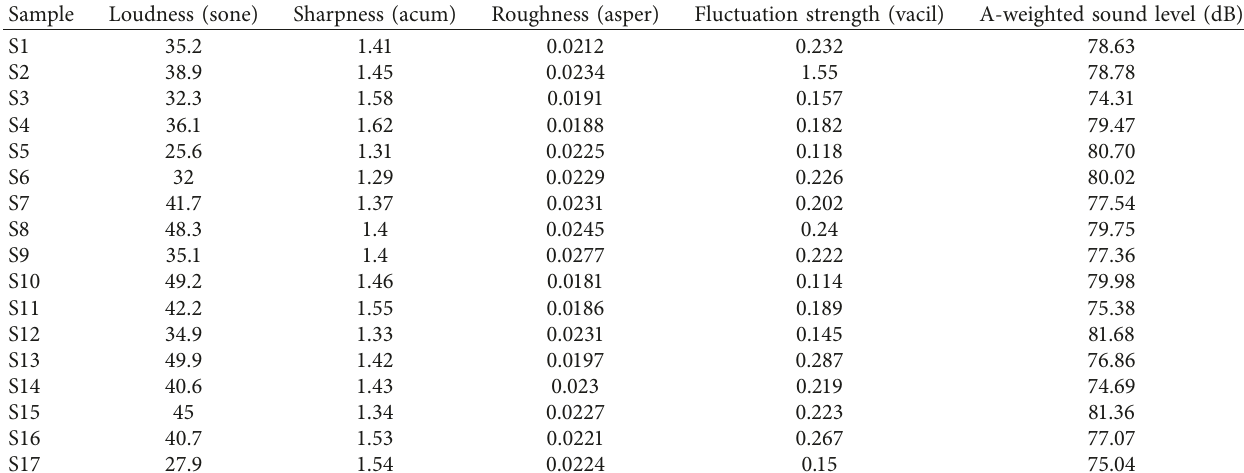
Table 3: The psychoacoustic objective parameters.